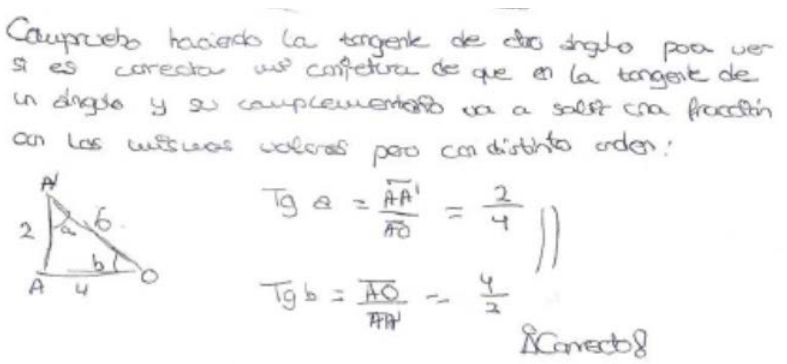
Figure 3. Claudia’s double check after doing the proof. Source: Claudia’s writing.